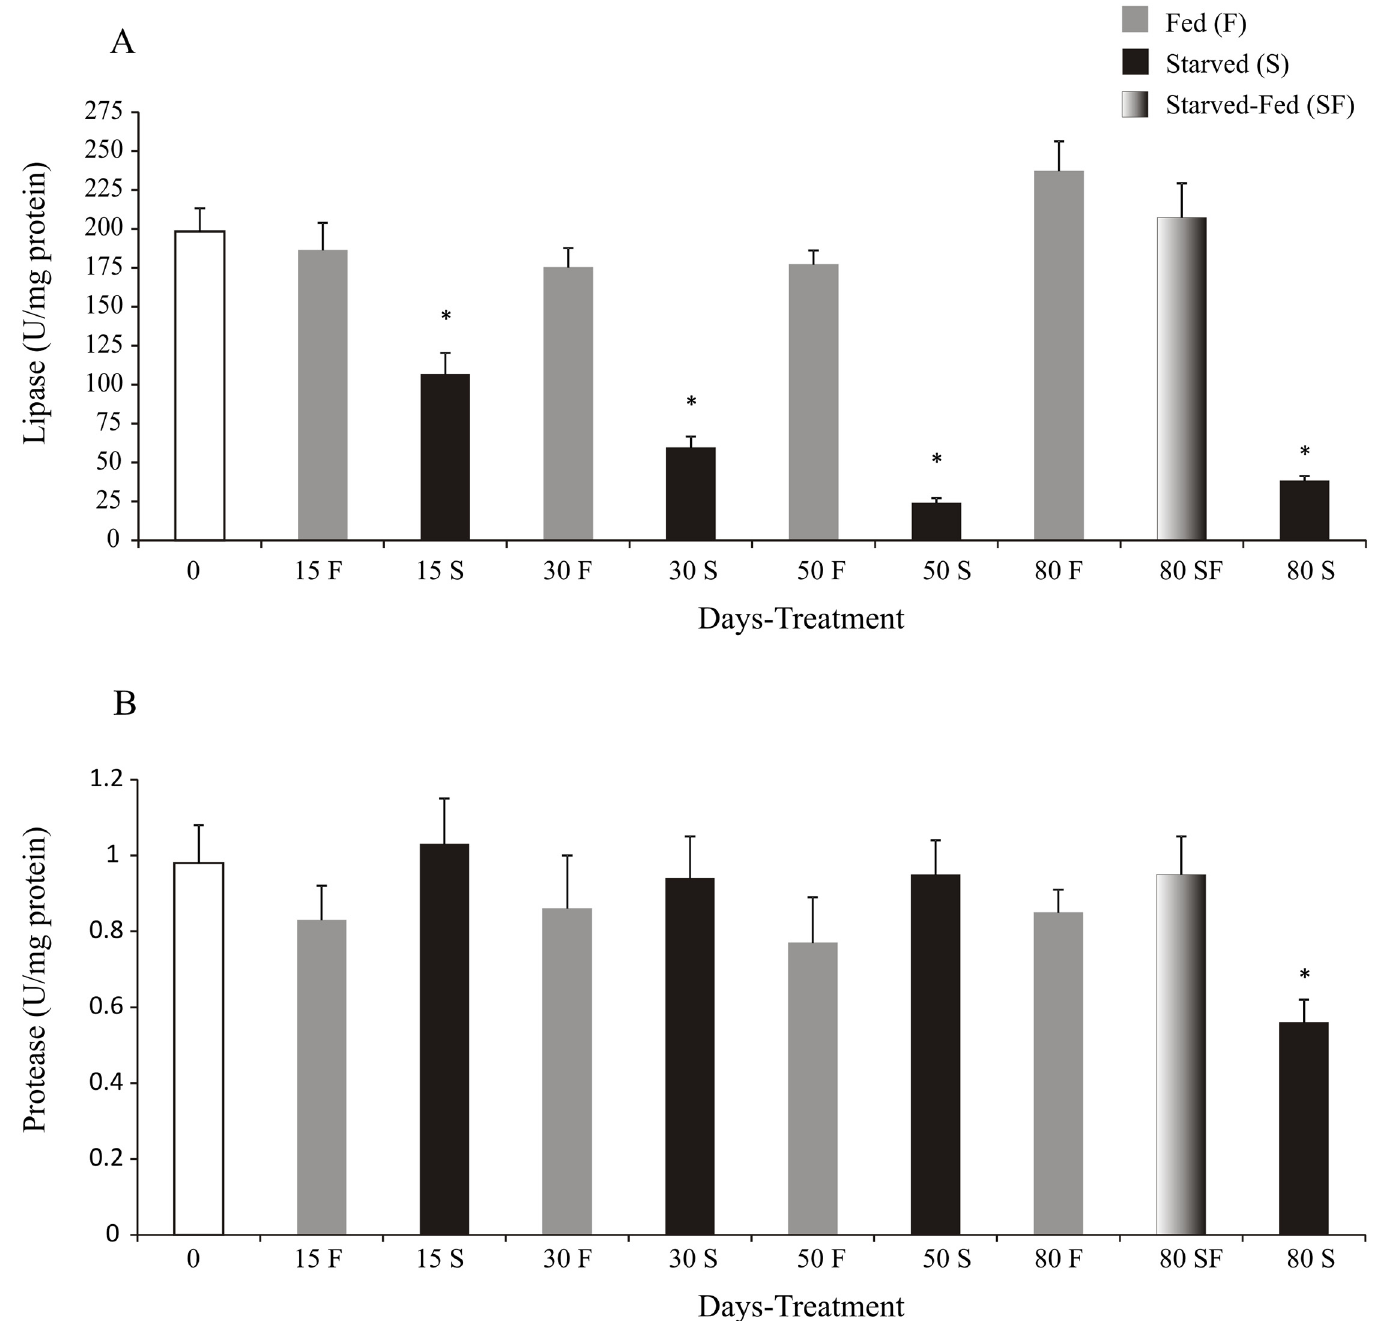
Fig 4. Cherax quadricarinatus juveniles´ protease and lipase activities after long starvation and posterior feeding. The statistical analysis was done among treatments (F, S and SF) at each experimental time (15, 30, 50, and 80 days). * indicates statistically significant differences (p <